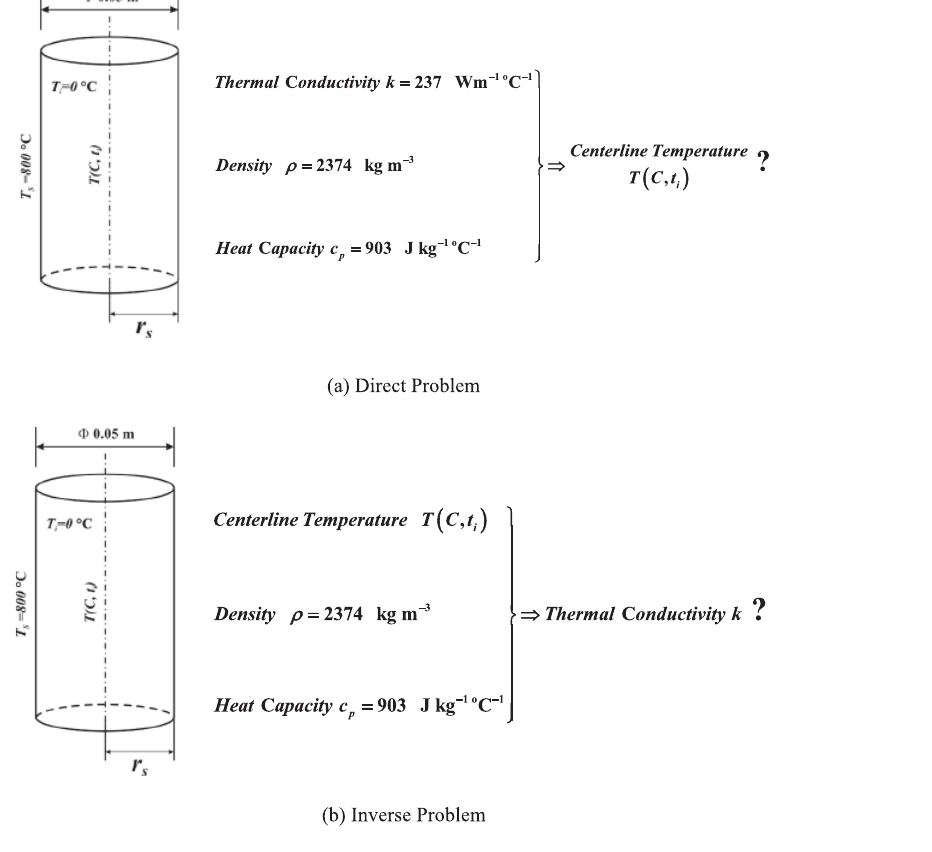
Fig. 10: Detail description of virtual experiment developed for validation of IHTP